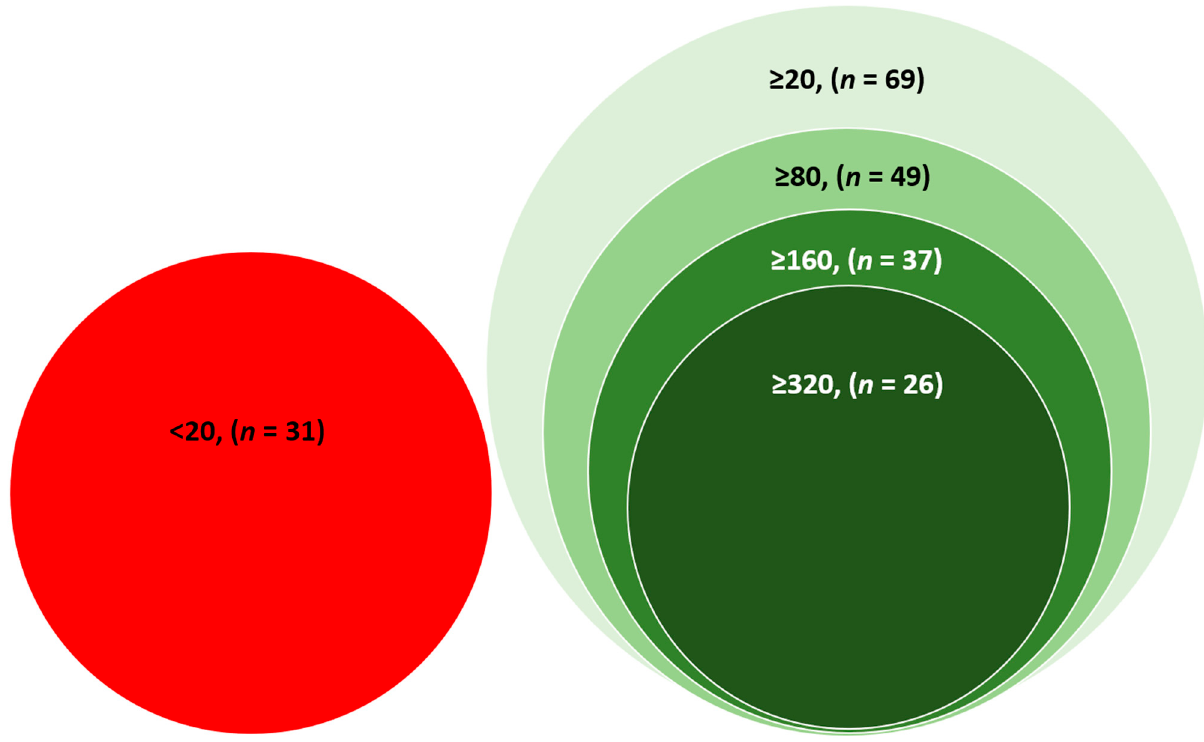
Figure 1. Venn diagram showing the PRNT 50 titre of the study participants (<20 titres is considered negative, ≥ 20 is considered positive for the presence of neutralizing antibodies).